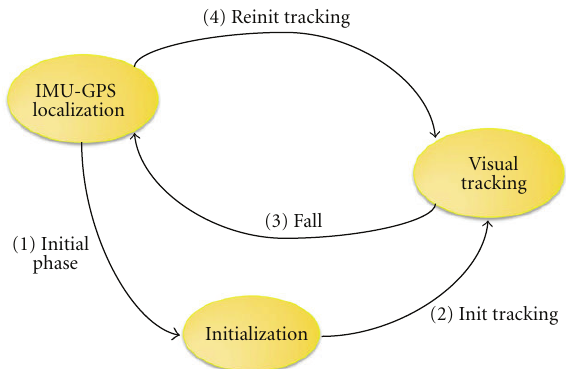
Figure 7: The state machine scheme of 3D localization system’s operation.